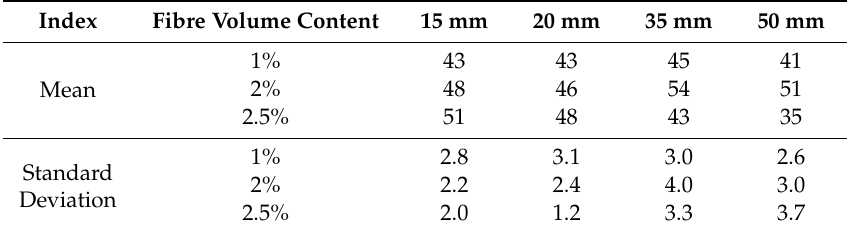
Table 7. Mean and STD of fibre orientation angles of all plates.